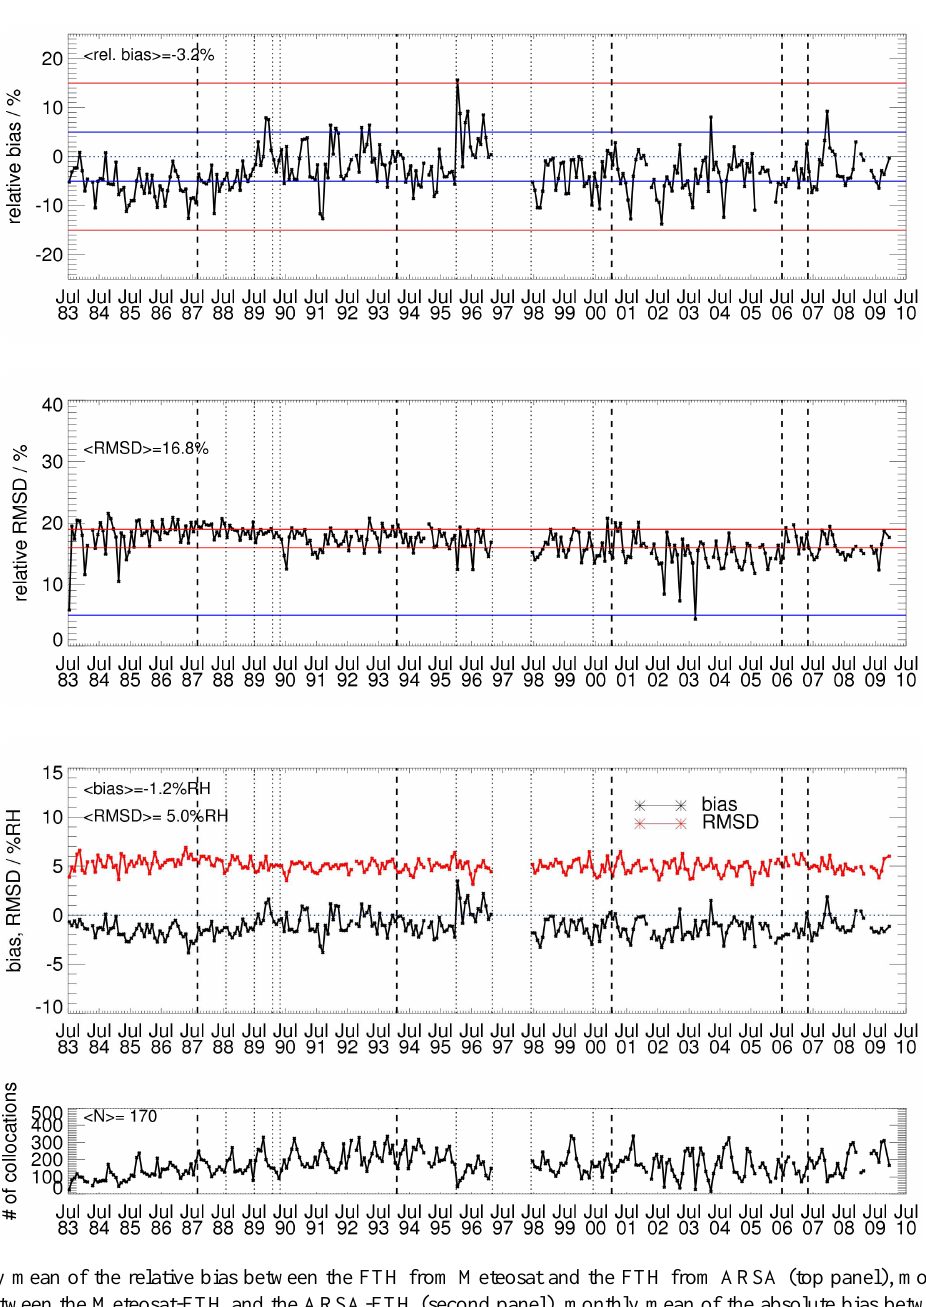
Figure 6. Monthly mean of the relative bias between the FTH from Meteosat and the FTH from ARSA (top panel), monthly mean of the relative RMSD between the Meteosat-FTH and the ARSA-FTH (second panel), monthly mean of the absolute bias between the Meteosat- FTH and the ARSA-FTH, monthly mean of the RMSD (third panel) and number of valid observations ( N , bottom panel). The thick dashed and the thin dotted vertical lines indicate homogenization and major radiometric events. The averaged bias, the averaged RMSD and the averaged N are also given. The colored lines in the first two panels highlight the FTH requirements from Global Climate Observing System (GCOS-154); the error budget estimate from Sect. 5; and a line at 15%, which is close to the peak values in maximum relative bias.